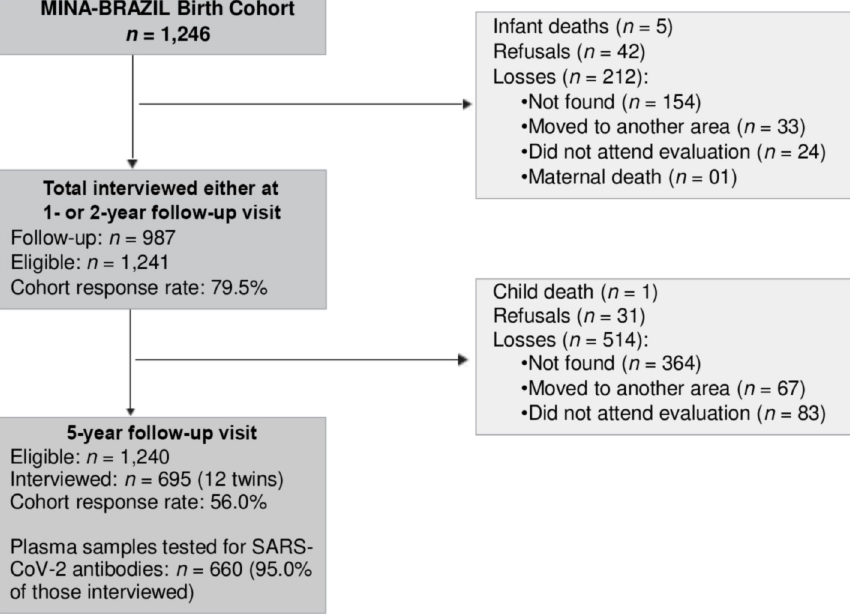
Fig 1. Study flowchart. Between July 2015 and June 2016, pregnant women attending antenatal clinics or admitted for delivery to the maternity ward of the Women and Children’s Hospital of Jurua´ Valley in Cruzeiro do Sul, Brazil, were invited to participate. Reasons for exclusion and the final number of subjects analyzed for SARS-CoV-2 antibodies at the age of 5 years are indicated.